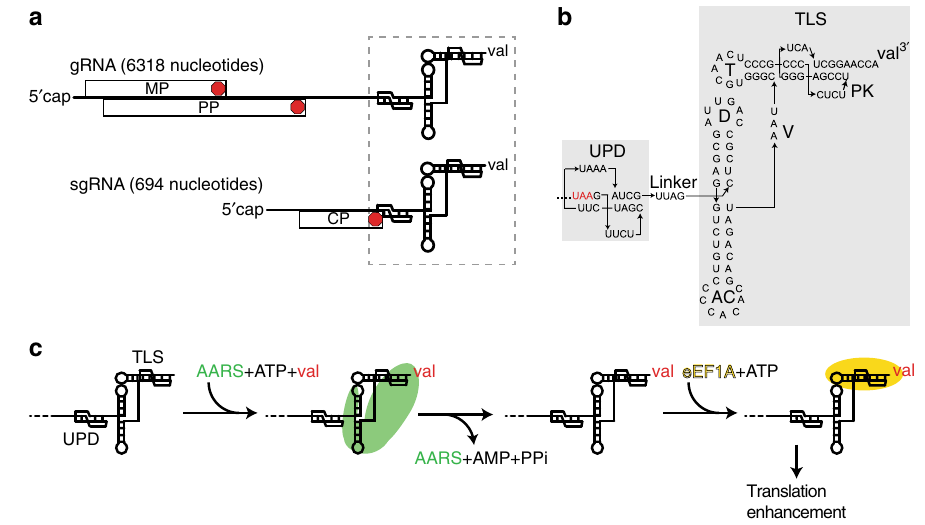
Fig. 1 Location, structure, and function of the TYMV 3 ′ -UTR. a TYMV gRNA and sgRNA. ORFs and the 3 ′ -UTR are labeled. MP movement protein, PP polyprotein, CP coat protein. Red: stop codons. The CP ORF is translationally silent in the gRNA. Both RNAs end with identical 3 ′ ends that contain the UPD + TLS domain and both are valylated (dashed box). b Secondary structure of the 3 ′ -UTR. Red: CP ORF stop codon. Speci fi c parts of the structure are labeled. c Schematic of TYMV TLS tRNA mimicry and translation enhancement. The 3 ′ end of the viral genome is aminoacylated by the host ’ s valine tRNA synthetase (green). This is followed by binding of eukaryotic elongation factor 1A (eEF1A, yellow) and translation enhancement by an unknown